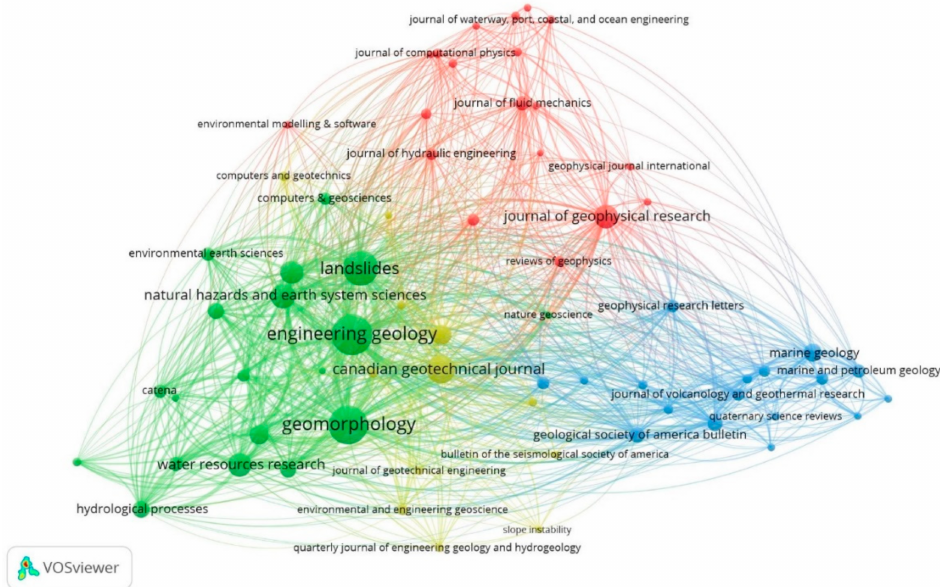
Figure 8. Visualization of the co-citation network assigning a representative color for each cluster (topics) and nodes (journals). According to the structure built using the VOSviewer software version 1.6.17. The colors red, green, blue and yellow appear in order of